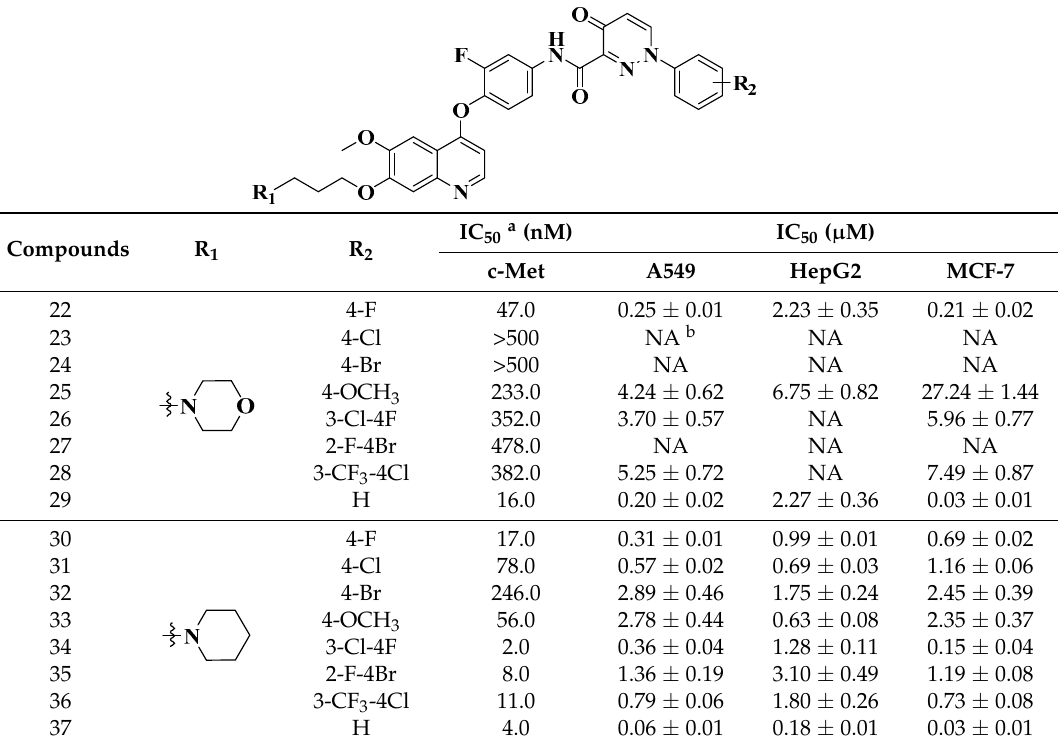
Table 1. c-Met Enzymatic and Cellular Activities of the target compounds 22 – 53 .